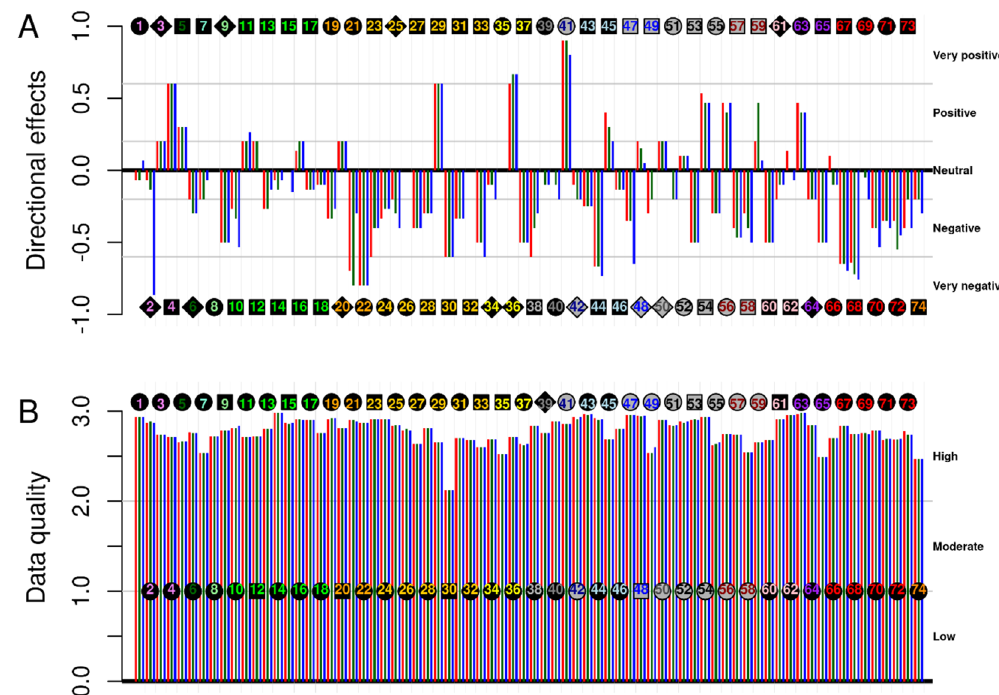
Figure 4. Expert-based assessments of overall directional effects of climate change ( A ), and data quality for the assessment of vulnerability ( B ). Species are identified by the species number, and functional groups are represented by the colour of the species number in the square [see legend in ( A )]. Geographic regions are represented as in Fig. 2. The symbol of the points in ( A ) represents the confidence in the directional effects’ assessment obtained during the bootstrap analysis: circle (very high), square (high), diamond (moderate). In ( B ), symbols represent the confidence in the bootstrap analysis on the vulnerability assessment. Note that these assessments are common for climate change scenarios RCP 4.5 and RCP